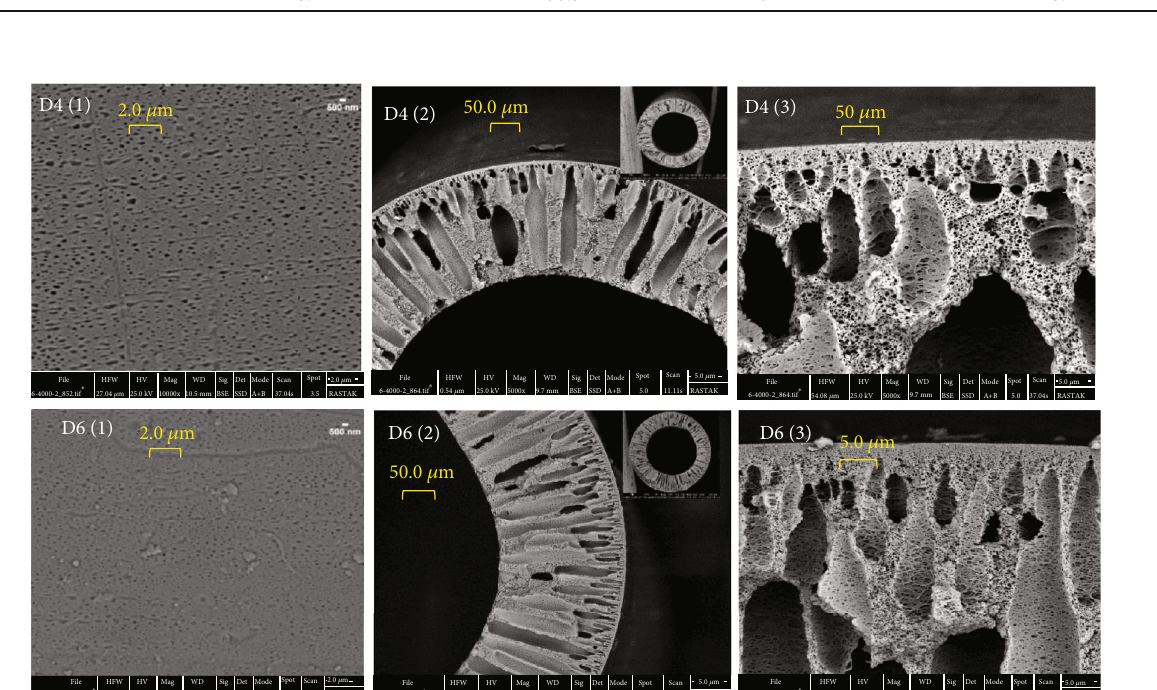
Figure 7: E ff ect of dope fl ow rate on morphologies of PAN hollow fi bers: (a) cross-section; (b) skin layer cross-section; (c) outer surface (D4: 4 ml/min, D6: 6ml/min). Table 4: The e ff ect of the dope fl ow rate on the pure water fl ux, porosity, mean pore size, and membrane wall thickness. Membrane code